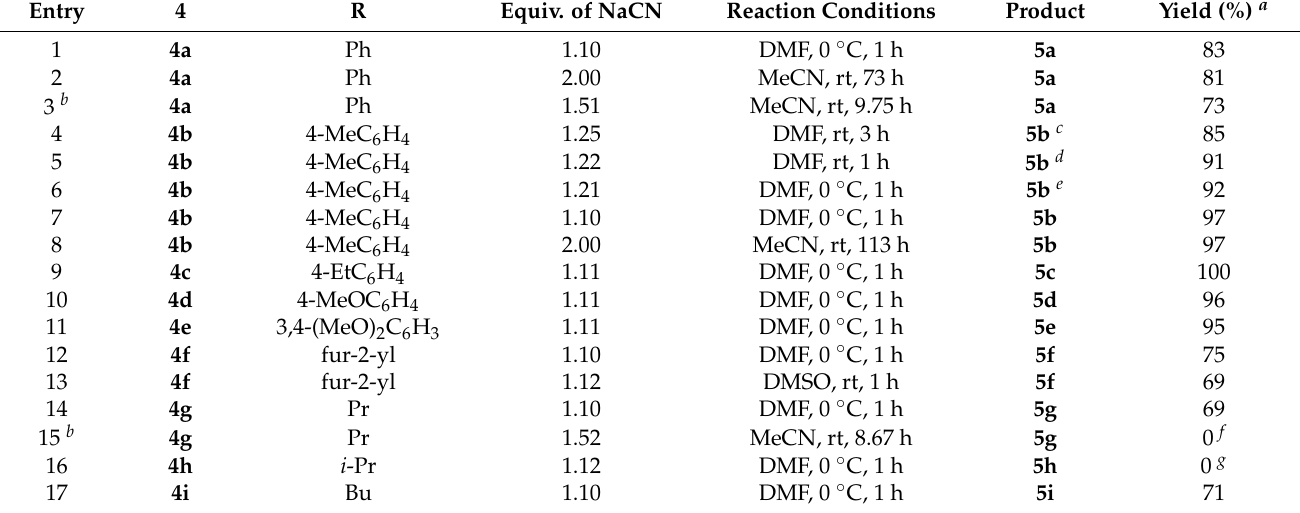
Table 2. Reaction N -(tosylmethyl)ureas 4a-i with sodium